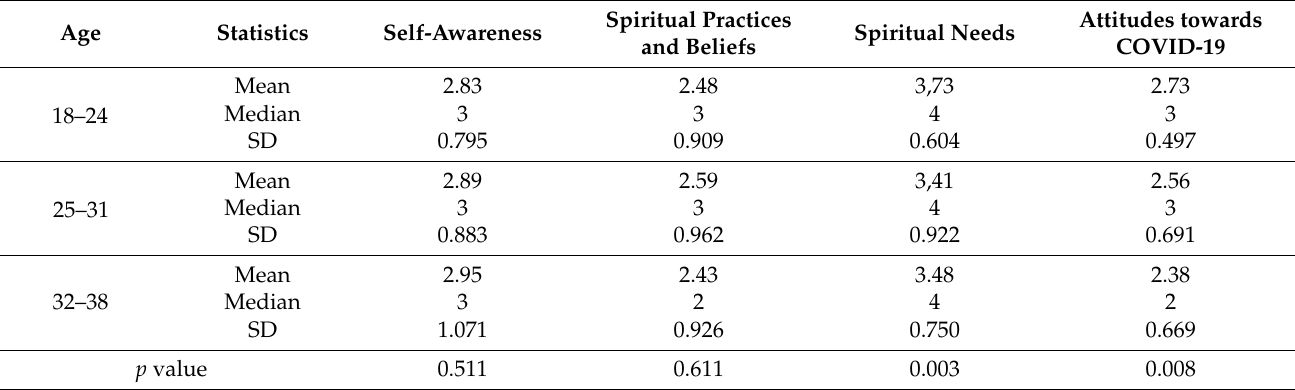
Table 6. Mean, median, and standard deviation (SD) by dimension according to students’